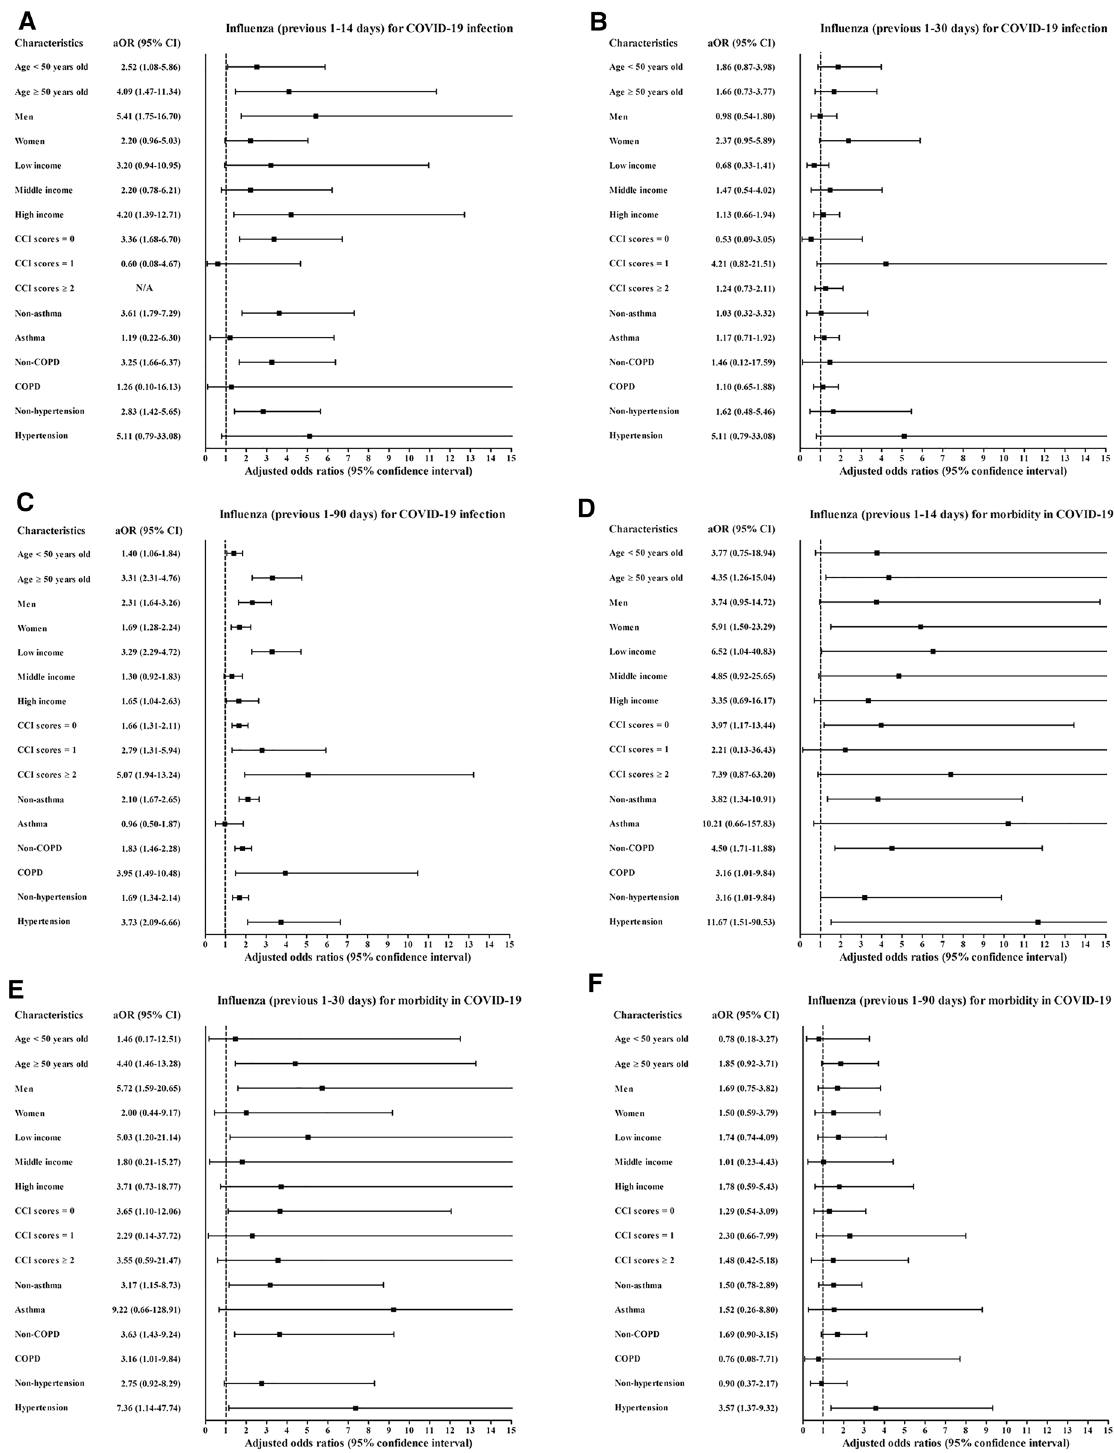
Figure 2. Subgroup analyses of the participants with COVID-19 by previous histories of influenza regarding ( A ) susceptibility for 1–14 days, ( B ) 1–30 days ( C ), and 1–90 days; ( D ) morbidity for 1–14 days, ( E ) 1–30 days, ( F ) and 1–90 days; and ( G ) mortality for 1–14 days, ( H ) 1–30 days, and ( I ) 1–90